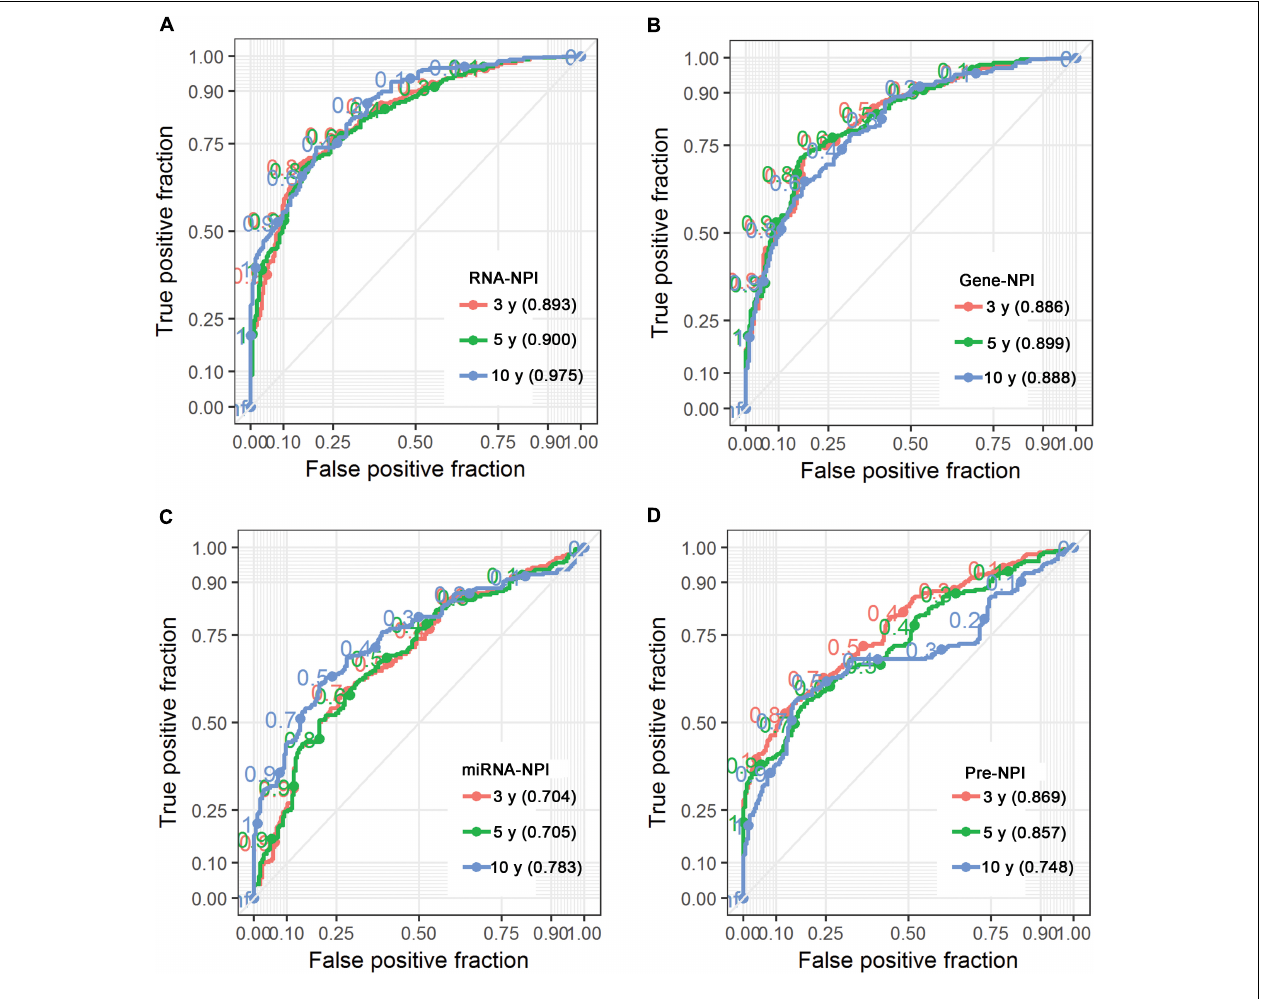
FIGURE 4 | Time dependent ROC for RNA-NPI (A) , gene-NPI (B) , miRNA-NPI (C) , and pre-NPI (D) .